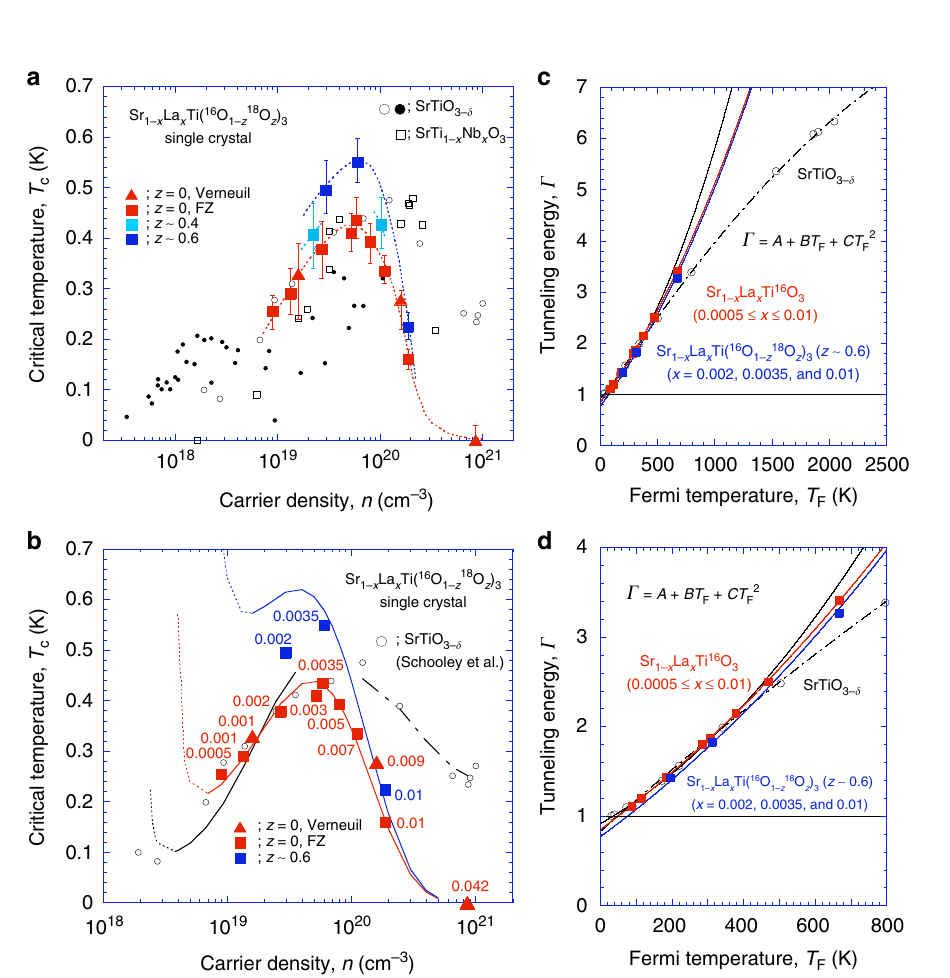
Fig. 3 Evolution of the superconducting dome with La substitution and 18 O exchange. a T c vs. n plot for the Sr 1 − x La x Ti( 16 O 1 − z 18 O z ) 3 single crystals shown in Figs. 1a and 2a. The upper and lower error bars are determined from the onset and end temperatures of the superconductivity (see Supplementary Figure 4). T c for SrTiO 3 − δ 21,28,31 , SrTi 1 − x Nb x O 3 31,34 , and La-substituted SrTiO 3 27 are also plotted. b The lines were obtained from calculations based on the model in ref. 18 , which are compared with some of the experimental data in a . c Tunnelling energy Γ vs. Fermi temperature T F deduced from the experimental values of T c and n using Supplementary Equations 1 and 2: Sr 1 − x La x TiO 3 (red squares) and Sr 1 − x La x Ti( 16 O 1 − z 18 O z ) 3 ( z = 0.6; x ~ 0.002, 0.0035, and 0.01) (blue squares) from this study; SrTiO 3 − δ (black circles) from the literature 21 . The experimental data were fi tted by the lines of Γ = A + BT + CT n relation represented by the lines in b . d The blow-up of c to emphasise where the Γ 2 . From these fi tting results for Γ , we obtained the T F F c vs. crosses Γ = 1 line The T c vs. n lines in Fig. 3b are based on the Γ vs. T F plots in Fig. 3b, the curves (solid and partially dashed lines) are plotted with the experimental data points. The black line is for SrTiO 3 − δ , Fig. 3c. Here, Γ is the tunnelling energy of the double-well potential 18 in analogy with that of magnetic phase transitions, the red line is for Sr 1 − x La x TiO 3 , and the blue line is for Sr 1 − x La x Ti( 16 O 0.4 18 O 0.6 ) 3 . Details of the calculation steps are and T F is the Fermi energy but we used the value of T F deduced provided in Supplementary Note 7. The model explains fairly well from the carrier density by assuming a free electron gas without the observed superconducting dome of Sr 1 − x La x TiO 3 . mass enhancement. The Γ vs. T F plot was obtained directly from NATURE COMMUNICATIONS| (2019) 10:738